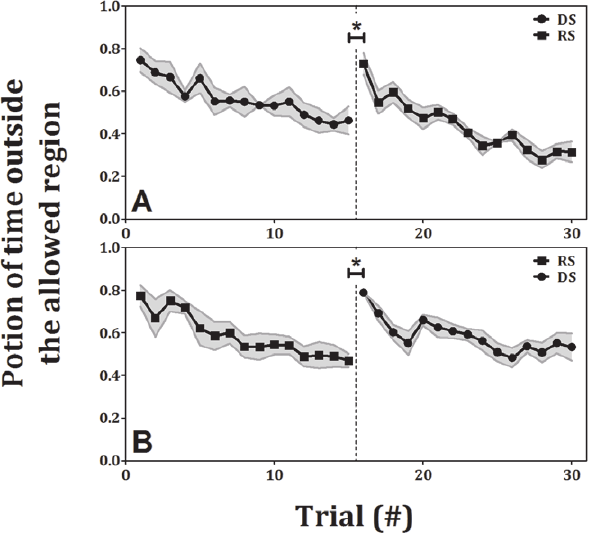
Figure 6. Error as a function of trial number for the children control experiment ( ± standard error). Each shape represents a different condition of the task: circles – discrete small, rectangles – rhythmic small. In both transitions, from discrete movements to rhythmic ones (panel A) and from rhythmic movements to discrete ones (panel B), there was a significant increase in